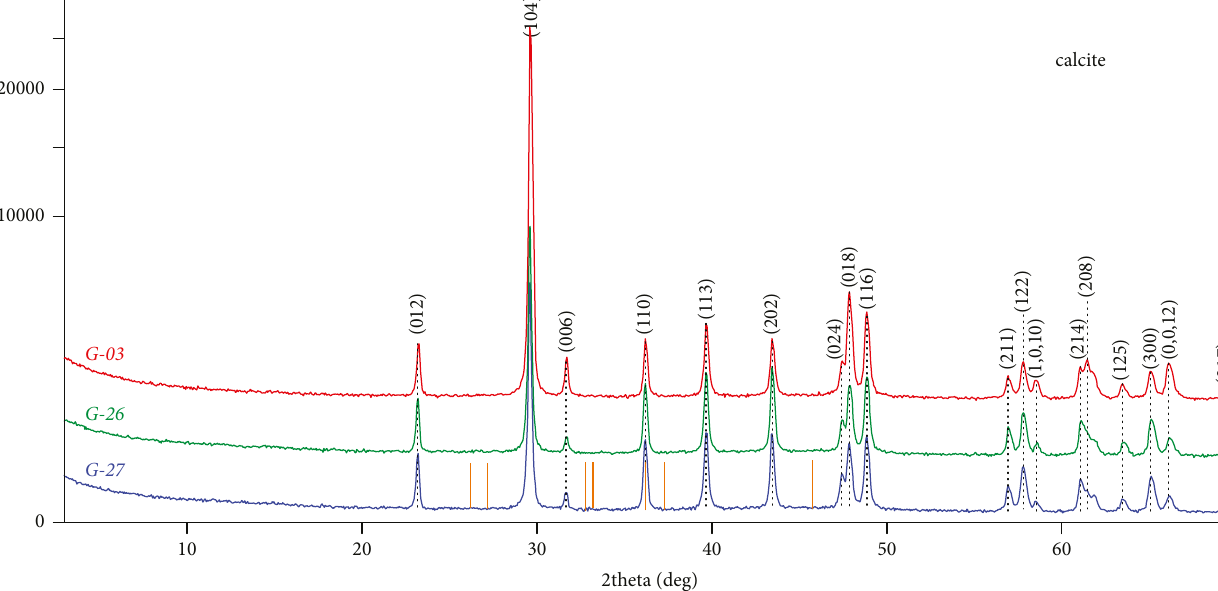
Figure 11: Typical XRPD patterns of representative scale samples (G-03: thick white scale, B1 zone; G-26 and G-27: thin dark brown scales formed inside pumps). Numbers in brackets at the peaks refer Miller indices. Orange lines indicate the diagnostic peaks of aragonite [44]. Note: aragonite (or another mineral phase) was not detected in the studied